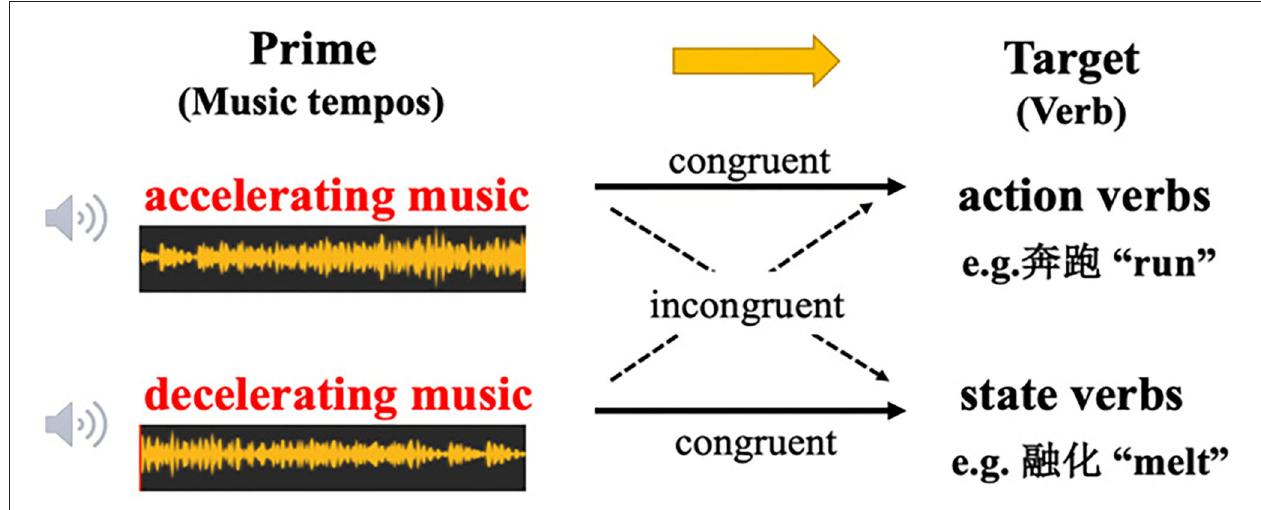
FIGURE 1 | Design of the cross-modality priming paradigm in task 1 of Experiment 1. Music tempos were used as primes, and verbs were used as